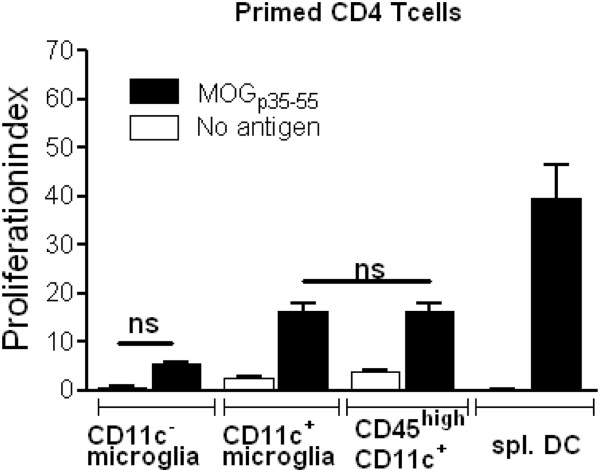
Relative efficiency of central nervous system and spleen antigen presenting cells in stimulating proliferation of myelin-specific CD4 T cells. Proliferation of CD4 T cells sorted from B6 mice with severe experimental autoimmune encephalomyelitis (EAE). Splenic CD4+ T cells from myelin oligodendrocyte glycoprotein (MOG)p35–55 immunised B6 mice with severe EAE were isolated using magnetic beads and cultured with antigen presenting cells (CD11c− microglia, CD11c+ microglia, CD45high CD11c+ cells and spleen-derived dendritic cells (spl. DC), with (black bars) or without (white bars) MOGp35–55. Proliferation was measured by CFSE dilution assay. Data are presented as means ± SEM of three individual experiments (n ≥ 9 ). ns, Non-significant differences (P > 0.05).